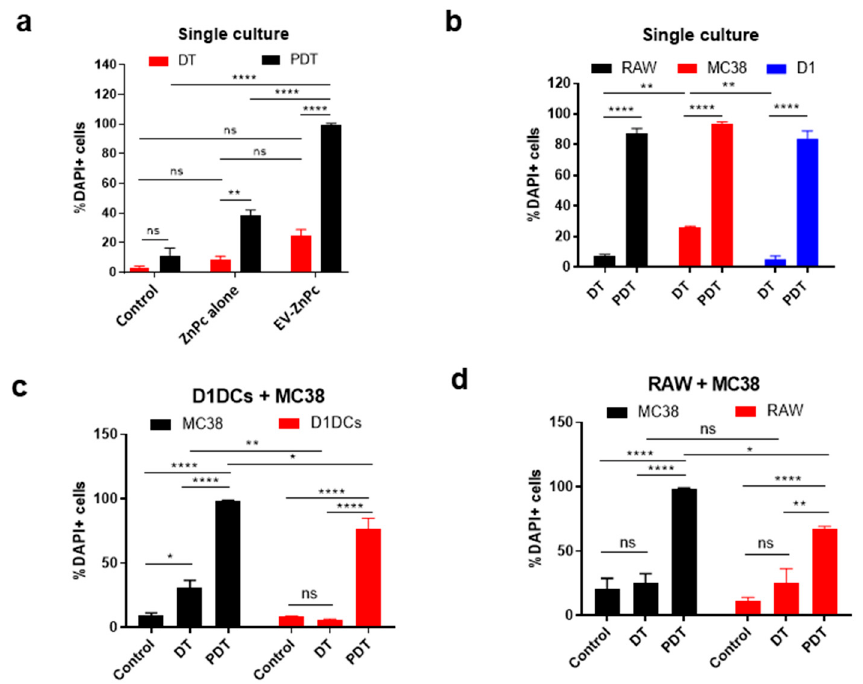
Figure 3. EV-ZnPc effect on normal and tumor cells after PDT in vitro. ( a ) MC38 cells were incubated with ZnPc alone or EV-ZnPc cells prior to evaluation of dark toxicity (DT) and PDT-induced cytotoxicity by flow cytometry using Annexin-V/DAPI staining. PDT efficacy was evaluated in RAW, MC38, and D1DCs cells in ( b ) normal culture models and co-cultures of ( c ) D1DCs + MC38 and ( d ) RAW + MC38 cells. CFP and CD11b/c were used to distinguish the uptake between tumor cells and D1DCs or tumor cells and macrophages. Data are means ± SEM ( n = 3). **** p < 0.0001; ** p < 0.01; * p < 0.05.